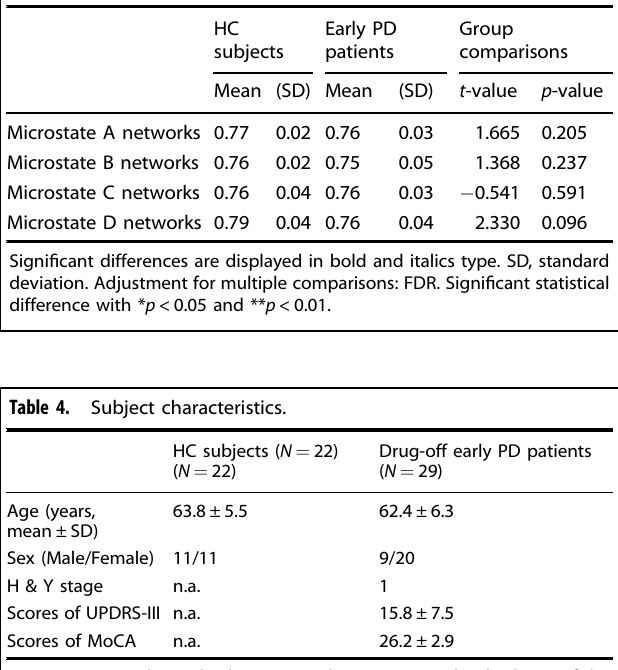
Table 3. Descriptive statistics of spatial variability of whole brain microstate functional connectivity networks in patients with early PD and healthy controls.